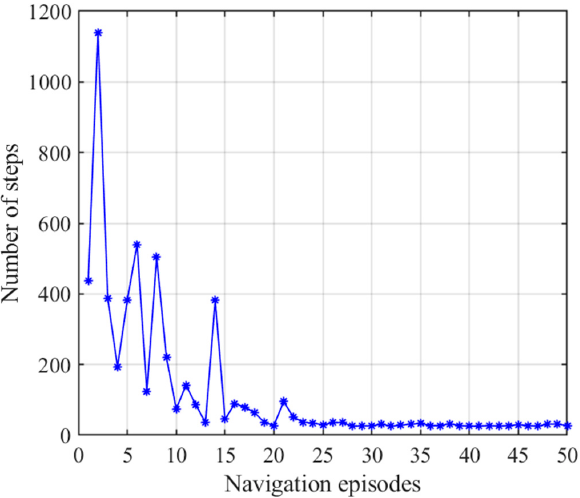
Figure 11. Number of steps with the striatal model alone. Blue asterisks indicate the navigation steps for each navigation episode.